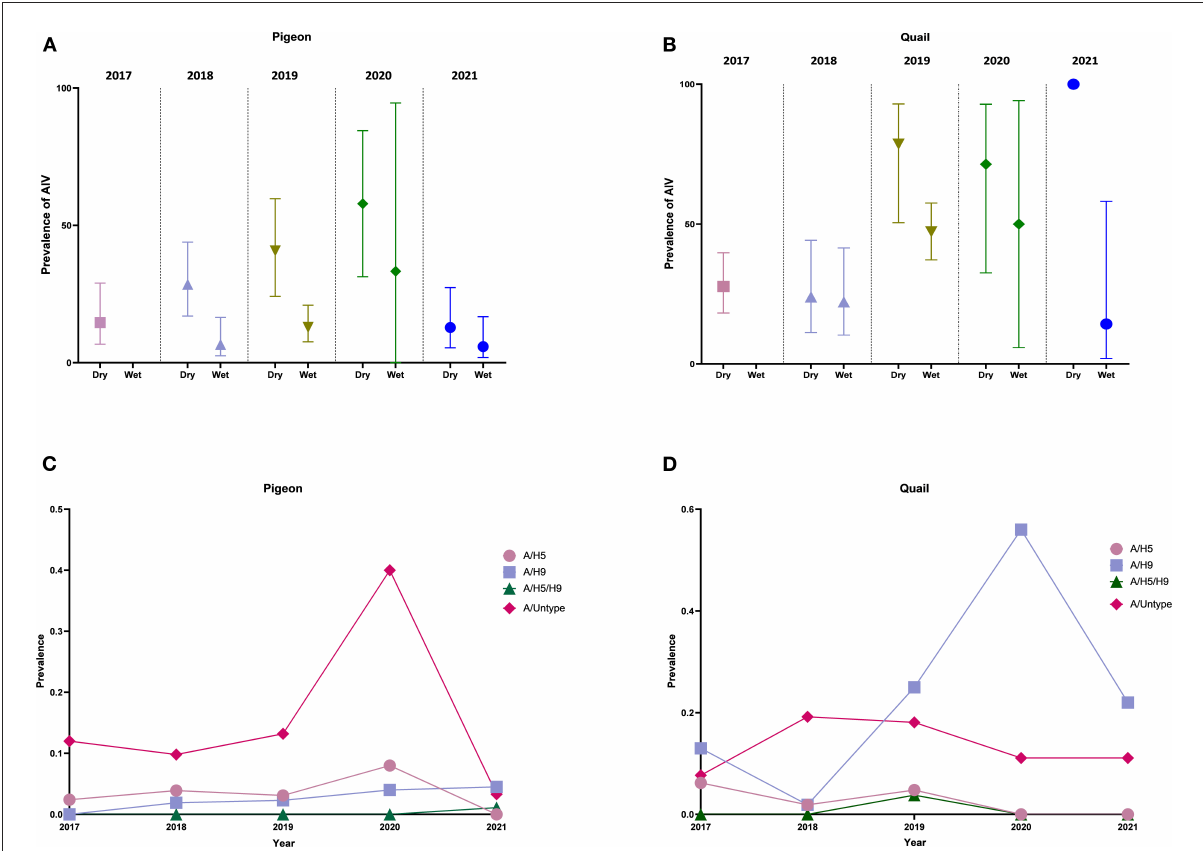
FIGURE3 Seasonal pattern and temporal trend of prevalence of AIV and subtypes (2017–2021). (A) Prevalence and 95% Confidence Interval of AIV in pigeons in dry and wet seasons. (B) Prevalence and 95% Confidence Interval of AIV in quail in dry and wet seasons. (C) Temporal trend of AIV subtypes in pigeons from 2017 to 2021. (D) Temporal trend of AIV subtypes in quail from 2017 to